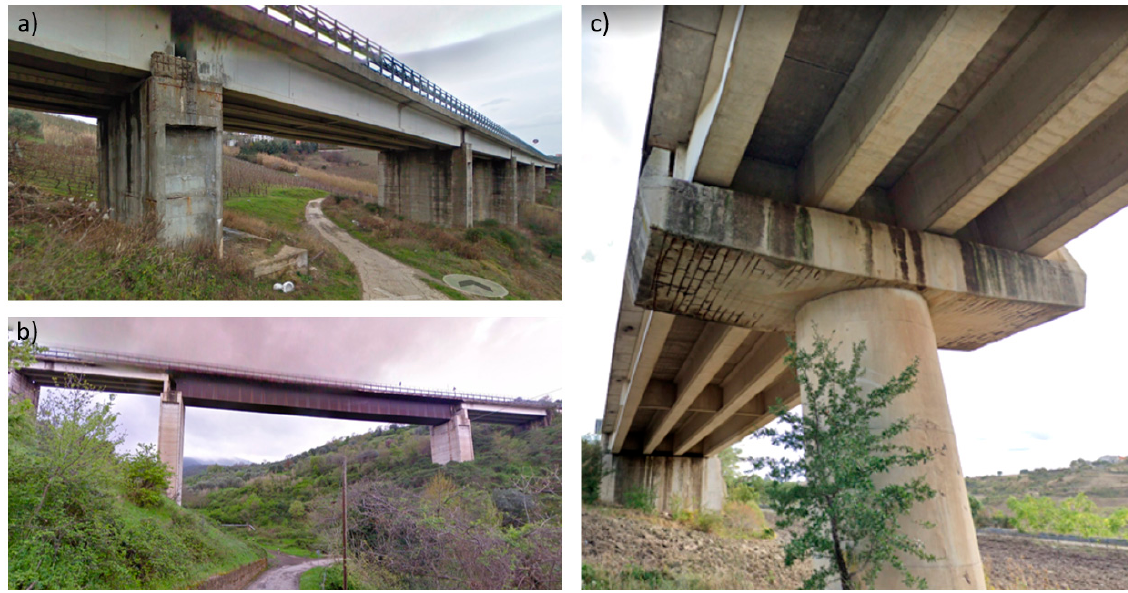
Figure 5. ( a ) Typical PRC viaduct, ( b ) steel span of a viaduct and ( c ) circular piers with cap beam.